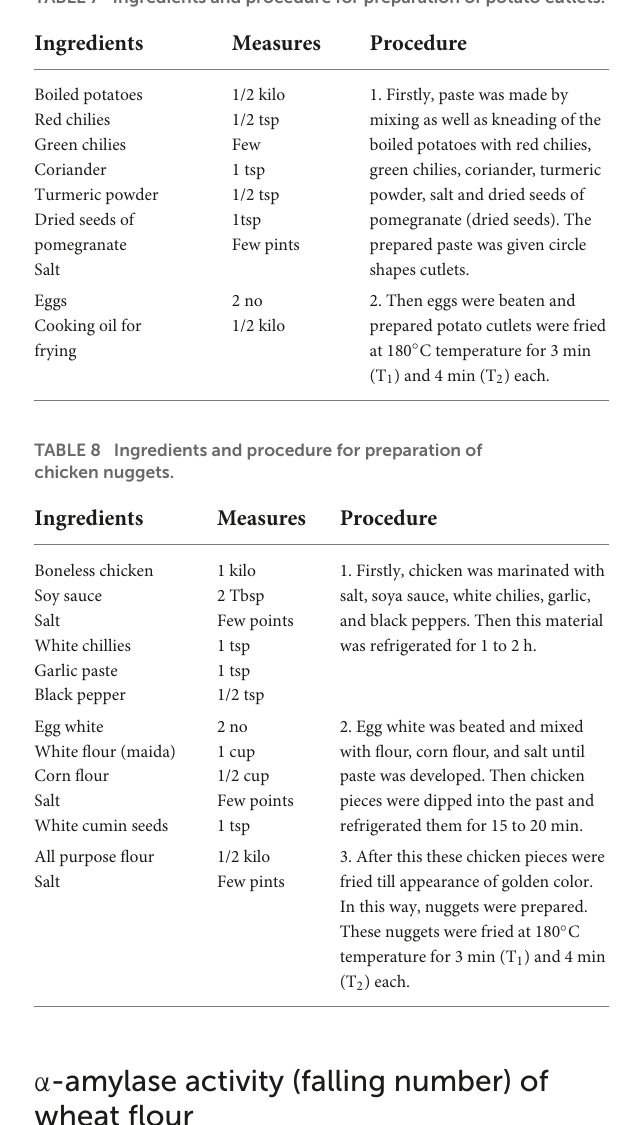
TABLE 5 Ingredients and procedure for preparation of samosa.